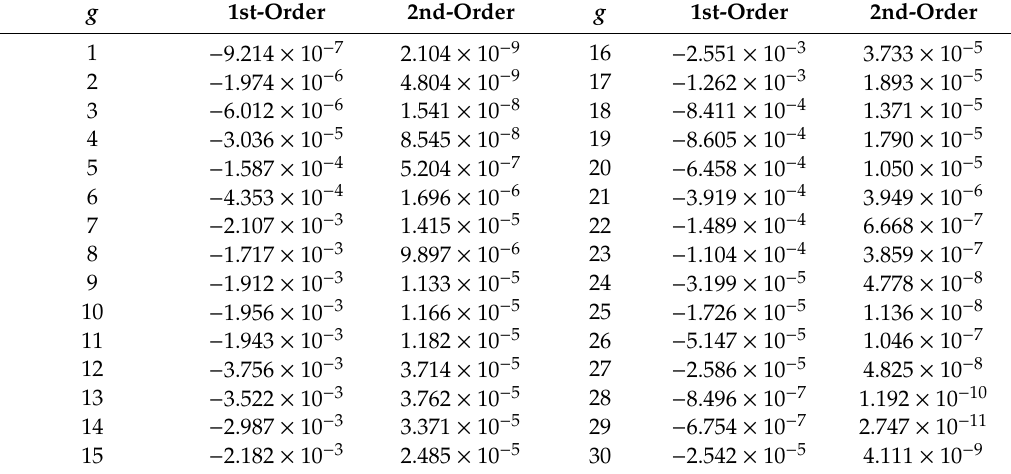
(cid:16) (cid:17)(cid:16) (cid:17) ∂ L / ∂σ g σ g / L , g = 1, ... ,30 and t , i = 3 t , i = 3 (cid:16) (cid:17)(cid:16) (cid:17) ∂ 2 L / ∂σ g ∂σ g σ g σ g / L , g = 1, ... ,30, for isotope 3 ( 69 Ga). t , i = 3 t , i = 3 t , k = 3 t , k = 3